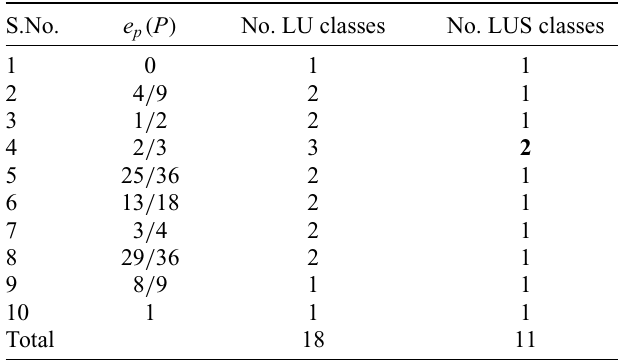
TABLE III. The entangling, LU, and LUS classes of dual (equivalently, T-dual) permutations in P ( 9 ) .